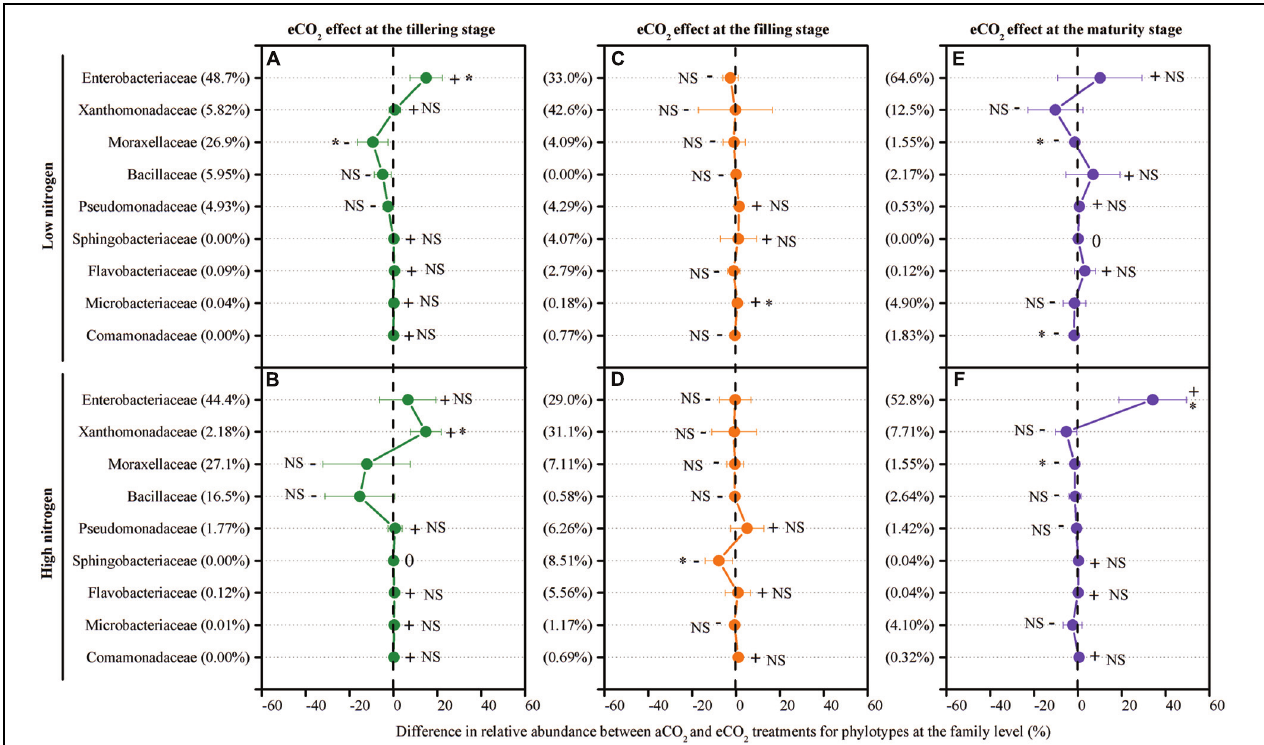
FIGURE 4 | The effect of eCO 2 on the relative abundance of leaf endophytic bacterial phylotypes at the family level at the tillering (A,B), filling (C,D), and maturity (E,F) stages. The eCO 2 effect was examined using the net difference in the relative abundance of bacterial taxa between the eCO 2 and aCO 2 . The net difference in the relative abundance was calculated as the relative abundance under eCO 2 minus the relative abundance of the phylotype under aCO 2 at each N treatment level. The percentage value in the bracket